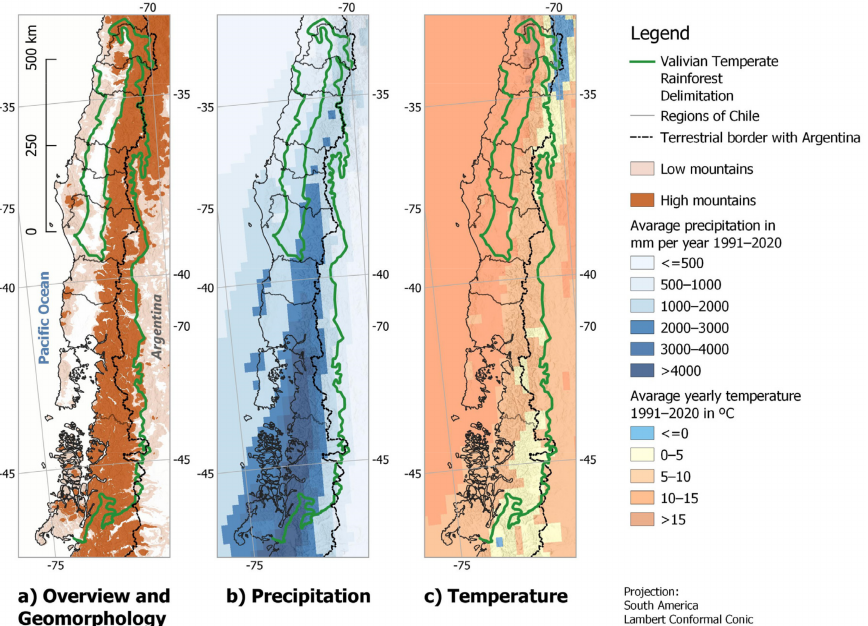
Figure 1. ( a ) Geomorphological ( b ) precipitation and ( c ) mean air temperature map of the Valdivian rainforest. Source: Own illustration out of databases mentioned in methodology section and Elevation Hillshade (Map Server)